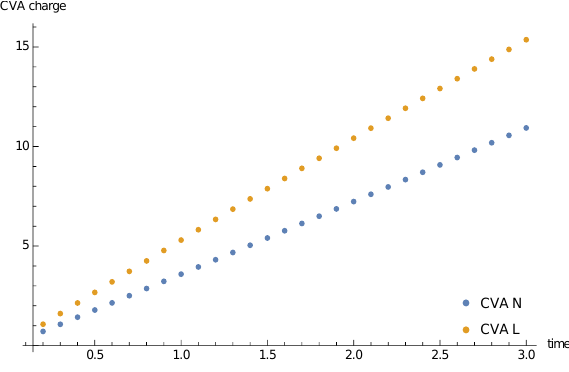
Figure 8. Comparison of CVA N and CVA L for Case B.